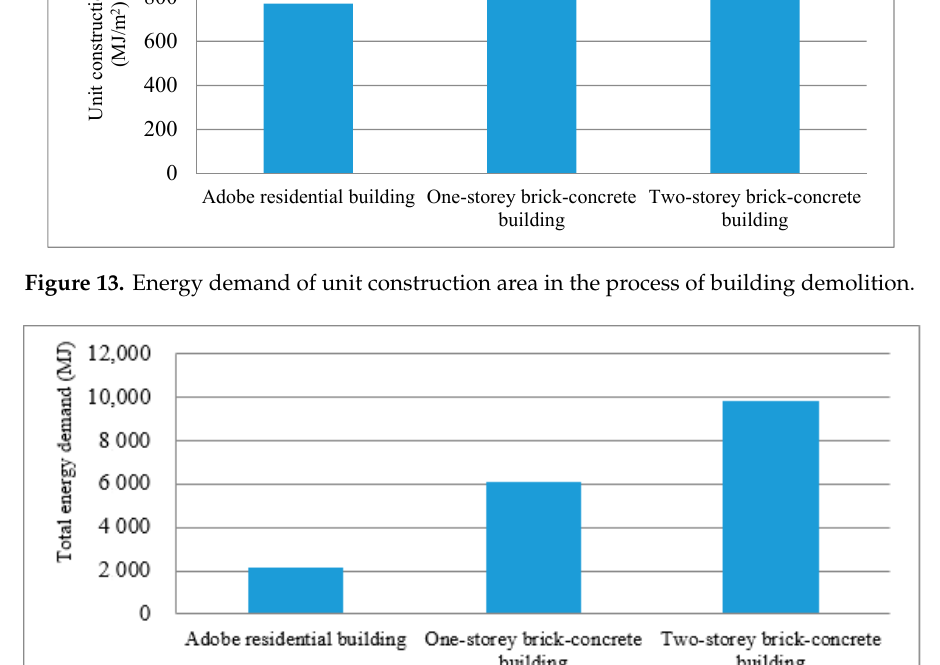
Figure 13. Energy demand of unit construction area in the process of building demolition.